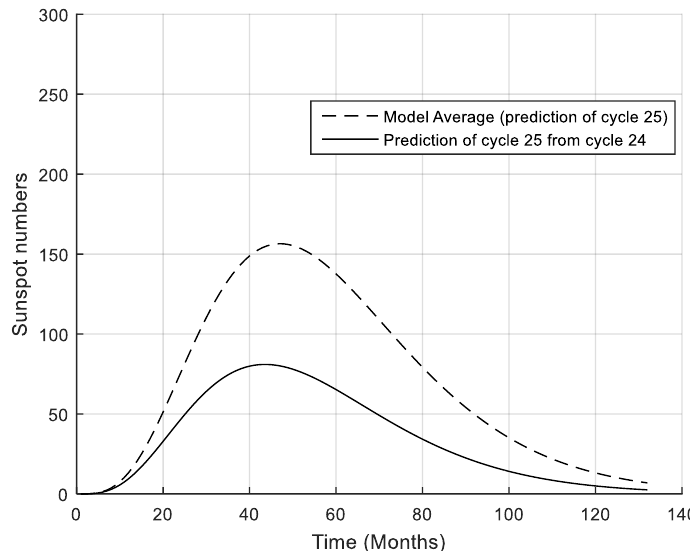
Figure 10. Prediction of Sunspot number cycle 25 Maximum peak occurring at 44 months with a sunspot number value of 81 units and 47 months with a sunspot value of 157